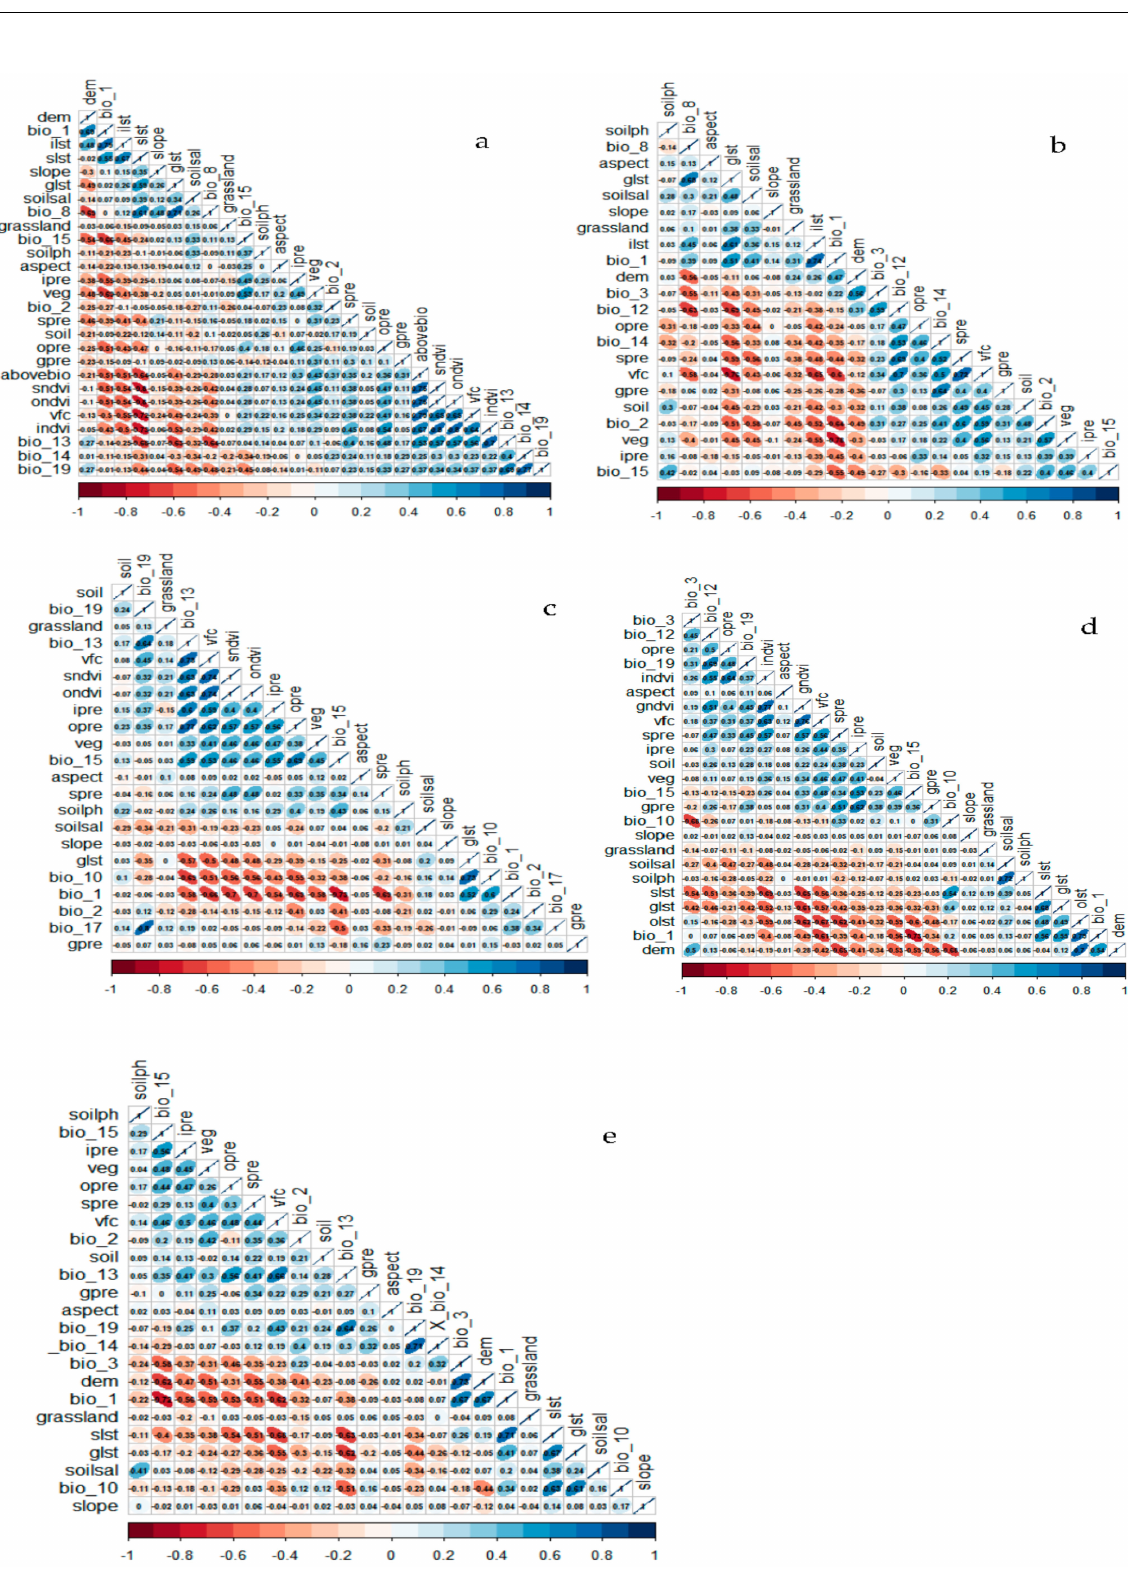
Figure 3. The correlations between selected variables at different density levels: ( a ) the low–density correlation coefficient; ( b ) the medium–low–density correlation coefficient; ( c ) the medium–high– density correlation coefficient; ( d ) the high–density correlation coefficient; ( e ) the all–points correlation